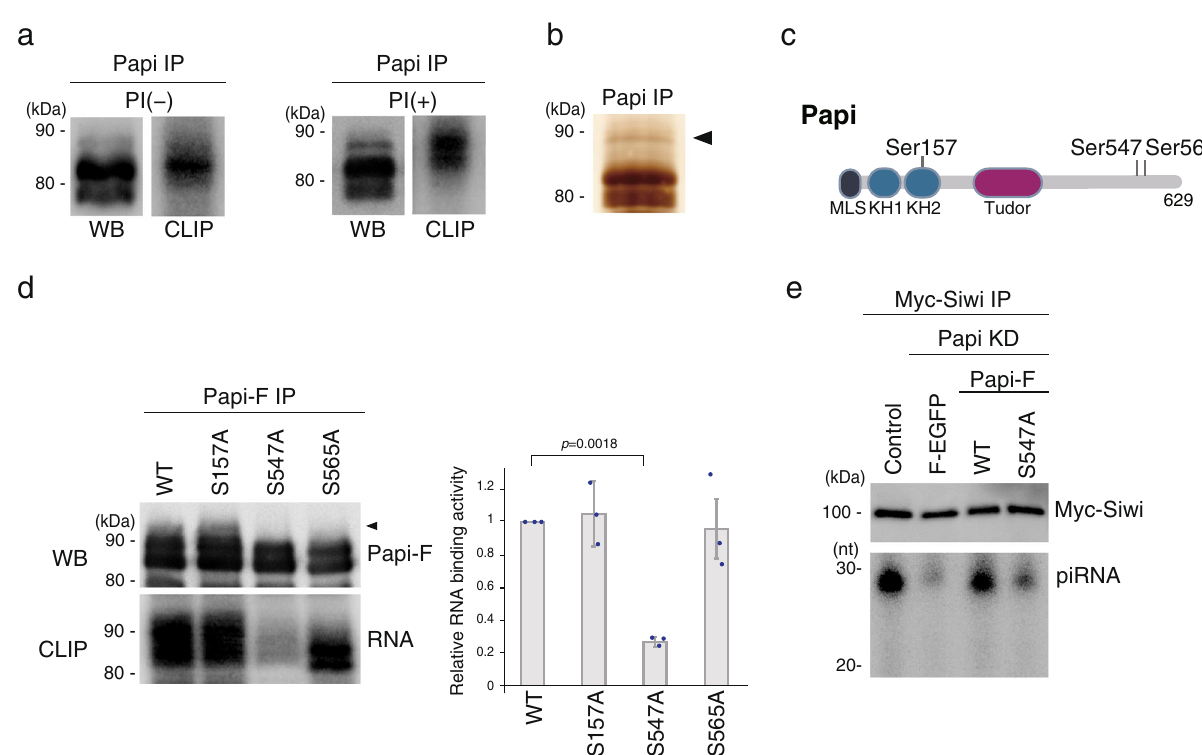
Fig. 1 Phosphorylation of Ser547 of Papi is necessary for Siwi-piRISC biogenesis. a Western blotting (WB) panels show band patterns of Papi in CLIP in the presence ( + ) and absence ( − ) of phosphatase inhibitor (PI). CLIP panels show the Papi-RNA complex labeled with 32 P ( n = 3). b Silver staining shows Papi immunoisolated from BmN4 cell lysates. The band that was used in the mass spectrometric analysis is indicated with a triangle ( n = 3). c Schematic drawing of Papi shows where Ser157, Ser547, and Ser565 are located. MLS mitochondrial localization signal, KH1 and KH2 K-homology domains. d CLIP panel shows that the RNA-binding activity of the S547A mutant was negligible, whereas that of other mutants was comparable to that of WT Papi. The topmost band in WT Papi is indicated with a triangle. Western blotting (WB) shows the band patterns of WT Papi and its mutants in CLIP. The statistical data of the CLIP signals ( n = 3) is shown (right). The signal intensities were calculated using ImageJ (National Institutes of Health) Each dot represents the intensity calculated from three independent experiments. P values were calculated by t -test (two-sided). Data are presented as mean values± SD. e WT Papi but not the S547A mutant restored Siwi-piRISC biogenesis in cells that lacked Papi [Papi knockdown (KD)] ( n = 3). The Papi-Flag (Papi-F) used in this experiment was RNAi-resistant. Control, Myc-Siwi was expressed in normal BmN4 cells; Flag-EGFP (F-EGFP) was used as a negative control. piRNAs were visualized by 32 P-labeling. The amounts of Myc-Siwi in Input and the knockdown ef fi ciency for Papi are shown in Supplementary Fig. 1e. Source data are provided as a Source Data fi